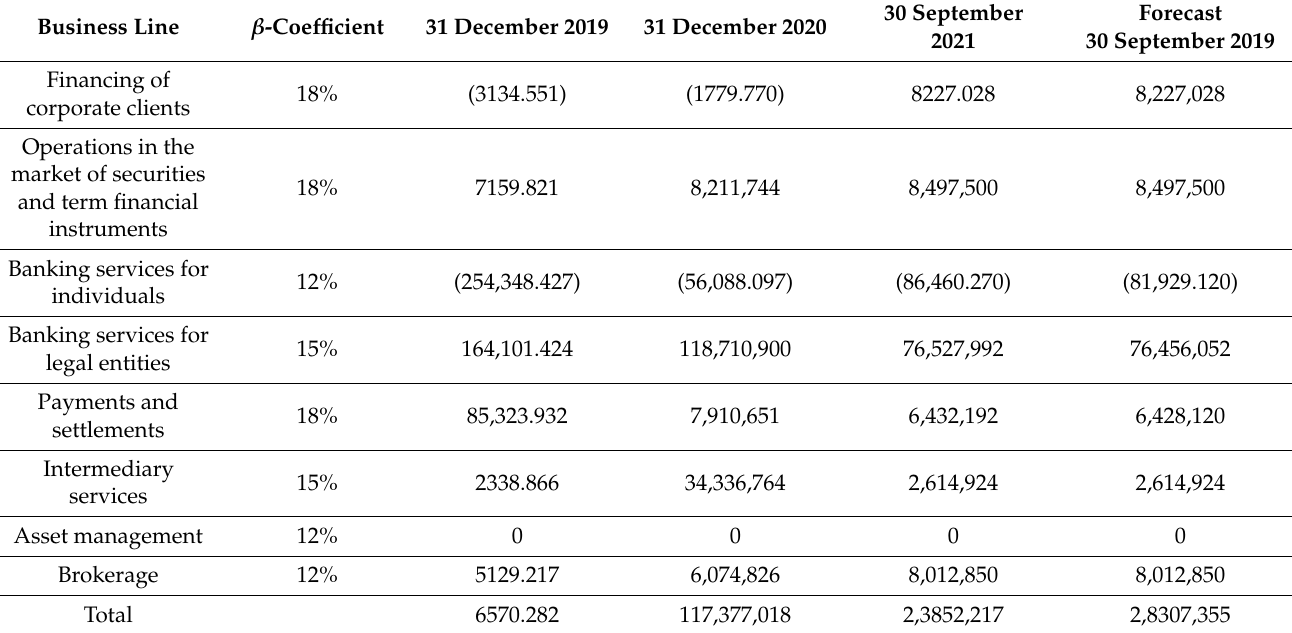
Table 6. Bank profitability by areas of activity according to the classification of the Basel Committee.